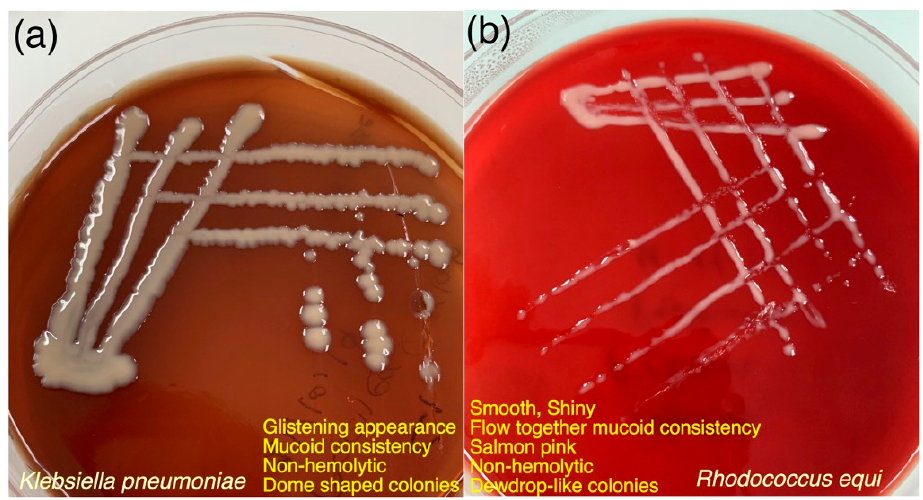
Figure 4. Growth appearance and colony characteristics of ( a ) K. pneumoniae and ( b ) R. equi on 5% defibrinated horse blood agar, isolated from trachea and pleural effusion samples of two cats investigated for acute/chronic infectious respiratory disease signs. Table 8. Summary of conventional biochemical tests, conducted to confirm the colonies of K. pneumoniae in Cat 01 and 02 and undifferentiated Klebsiella spp. in Cat 03 and R. equi in Cat 25, manifested acute/chronic infectious respiratory disease signs.